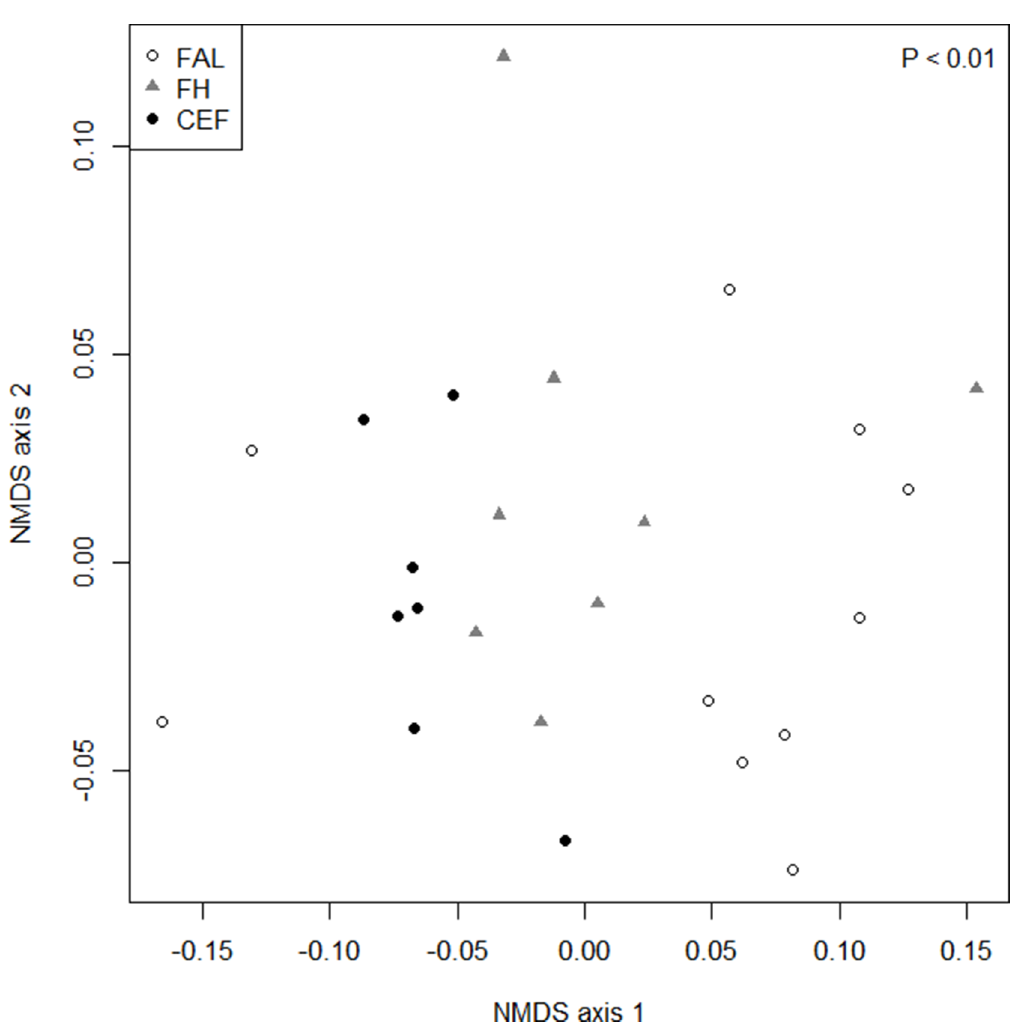
Figure 2. Similarity in temporal variation of growth rates in response to past land-use. Non-metric multi-dimensional scaling ordination (stress: 0.10) of site chronologies (period 1896–2005) of sessile oak ( Quercus petraea ) growing in oak forests with different land-use histories: Former arable land (FAL), former heathland (FH) and continuously existing forests (CEF). Site scores represent mean tree-ring width series derived from 10 trees per